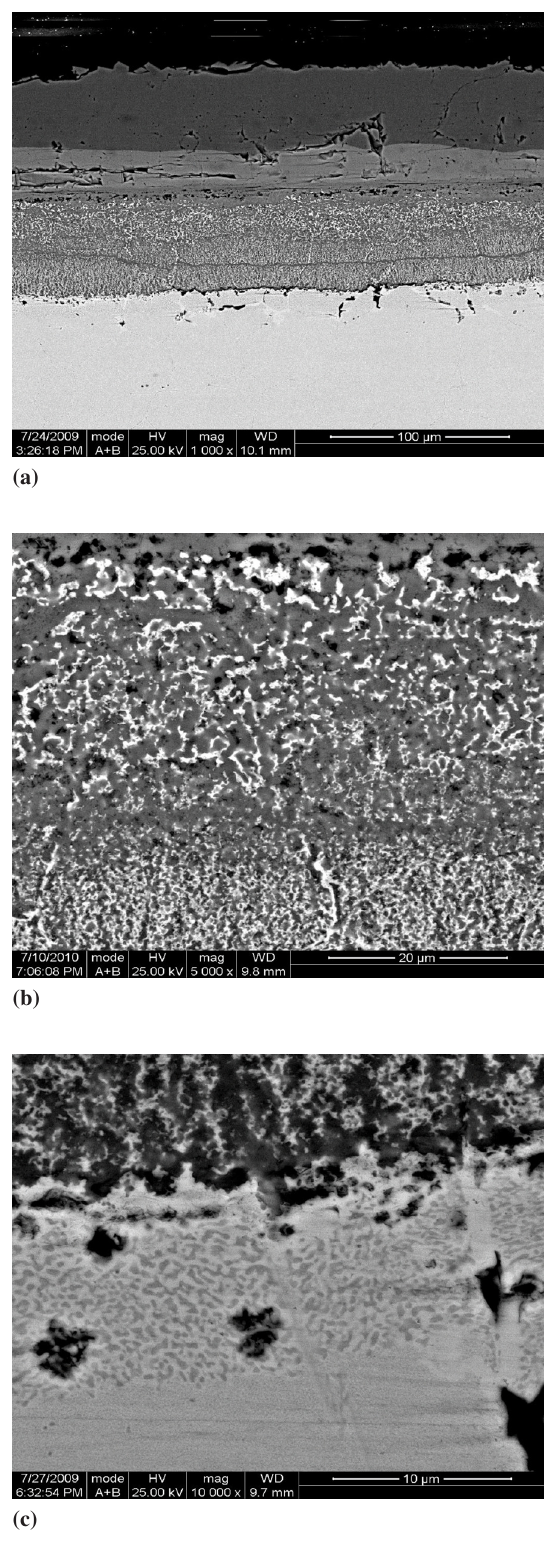
Figure 9. Cross-sectional morphologies of 310 SS corroded at 973 K in (Li,Na,K) 2 CO 3 -(Na,K)Cl for 500 h. (a) general view; (b) and (c) the amplified views of the inner layer of